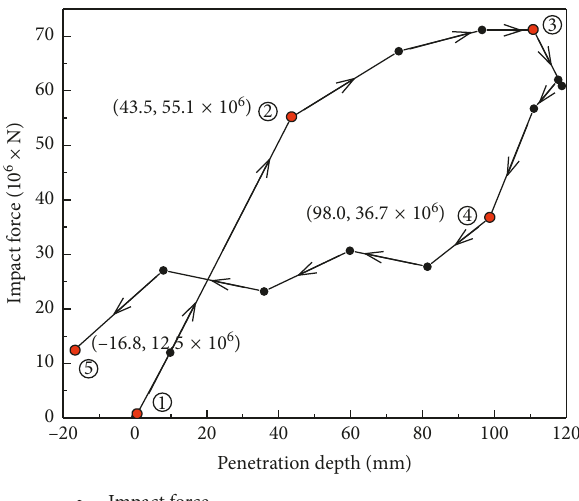
Figure 20: Time-history curve of the stress at impact